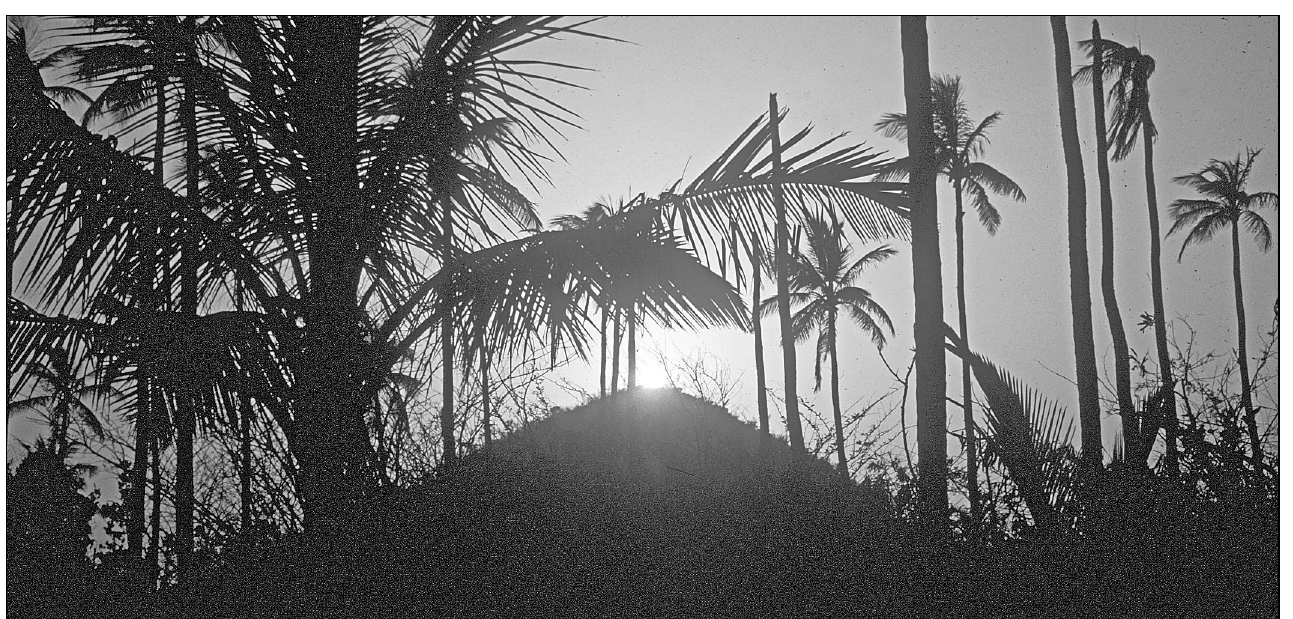
Figure 6 The Sun setting over Belmont Hill viewed from house I on midsummer’s